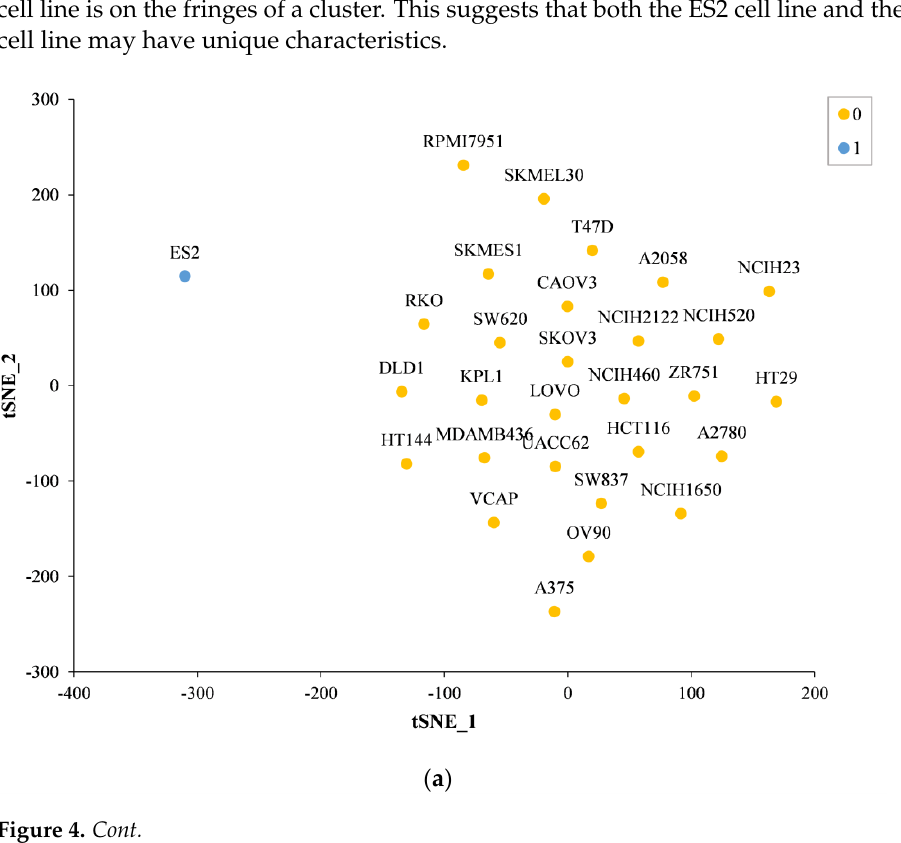
( b ) Figure 4. Different cell lines are subjected to t − SNE analysis to visualize the results. High − dimen- sional cell line vector representations are projected into 2D space with the first two t − SNE compo- nents. ( a ) Different colors indicate clusters per cell line assigned by the density − based spatial clus- tering of applications with noise (DBSCAN) clustering algorithm. ( b ) Different colors indicate dif- ferent tissues of each cell line.